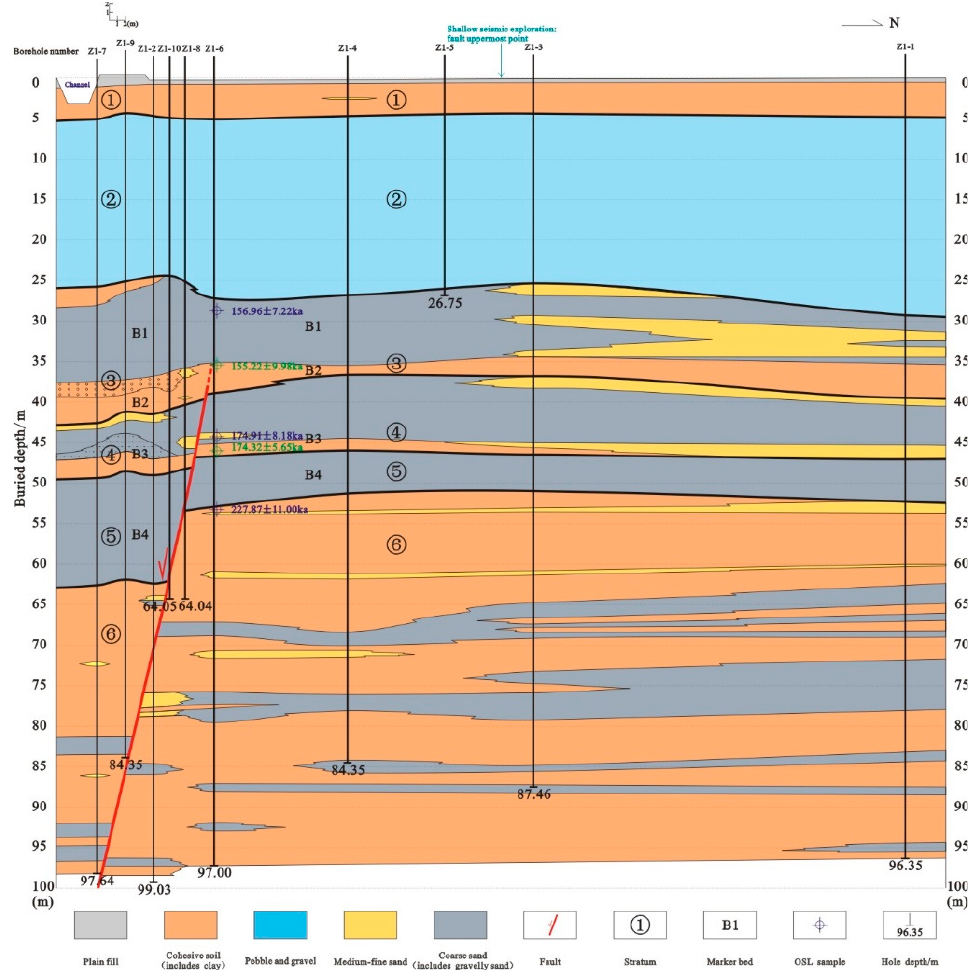
Figure 4. Stratigraphic lithology of composite drilling section in Xietan Village.